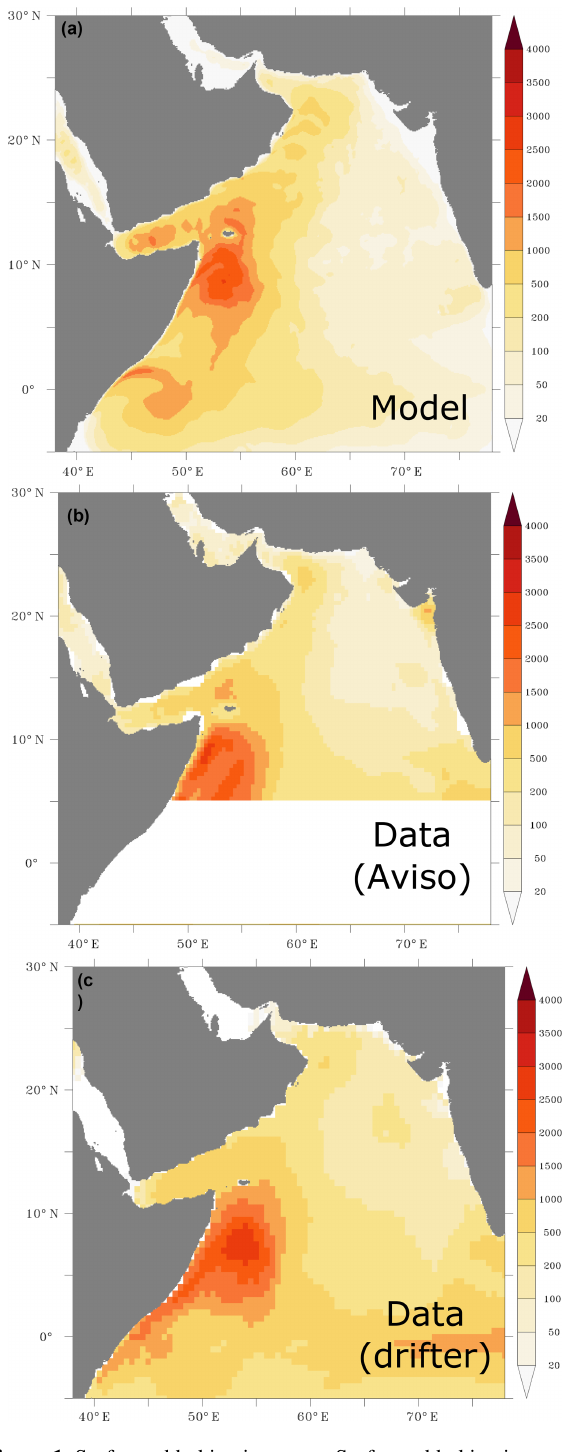
Figure 1. Surface eddy kinetic energy. Surface eddy kinetic energy (in cm 2 s − 2 ) as simulated in the model (a) and from data based on AVISO satellite altimeter (b) and surface drifter climatology of Lumpkin and Johnson (2013) (c)